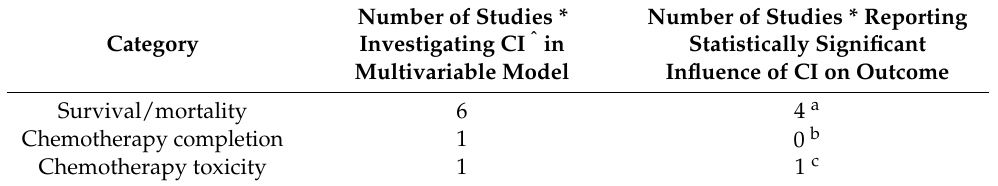
Table 2. Summary of